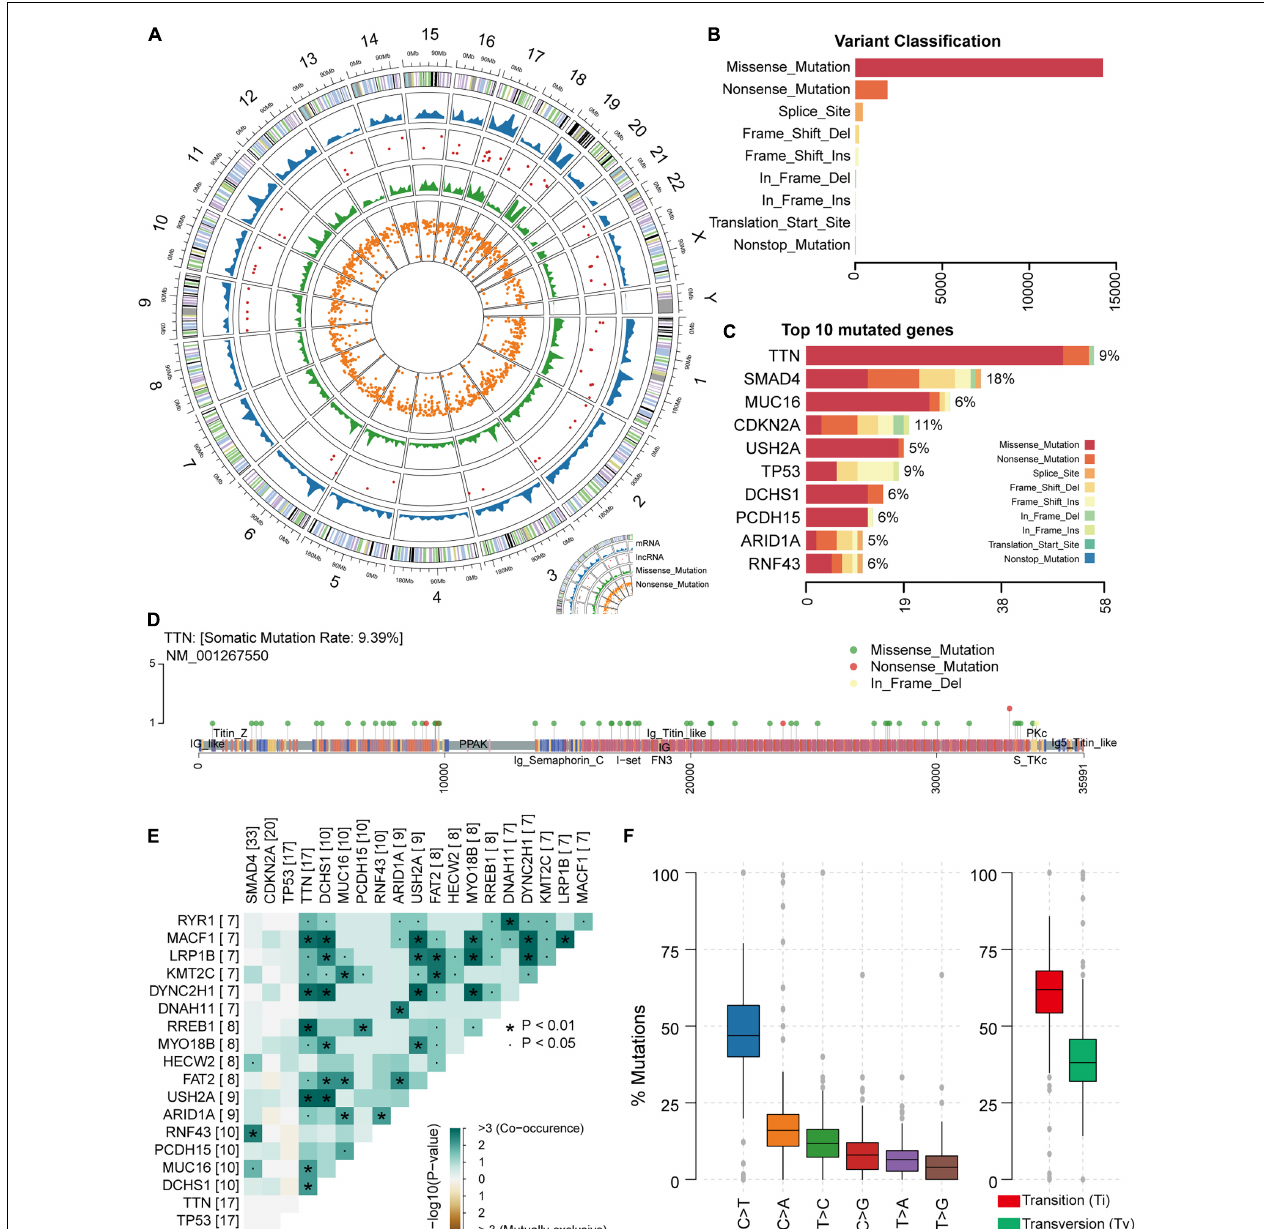
FIGURE 1 | Genomic overview of somatic mutations in PAAD. (A) The global view of genomic variations location. (B) Somatic mutations were classified into nine clusters according to function and location. The bar plot shows the number of mutations in each cluster. (C) The bar plot illustrates the proportion of each cluster of mutation in the top 10 genes in terms of number of mutations. The proportion of samples to which the mutation on each gene belongs was also calculated. (D) The location and type of mutations occurring on gene TTN were shown by the lollipop chart. (E) The mutation correlation between the top 20 high-frequency mutated genes. (F) The frequency of base substitutions (transitions and transversions) in